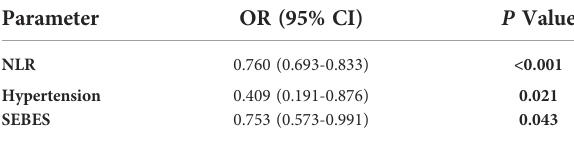
TABLE 2 Multivariate analysis of parameters associated with poor outcome at 3